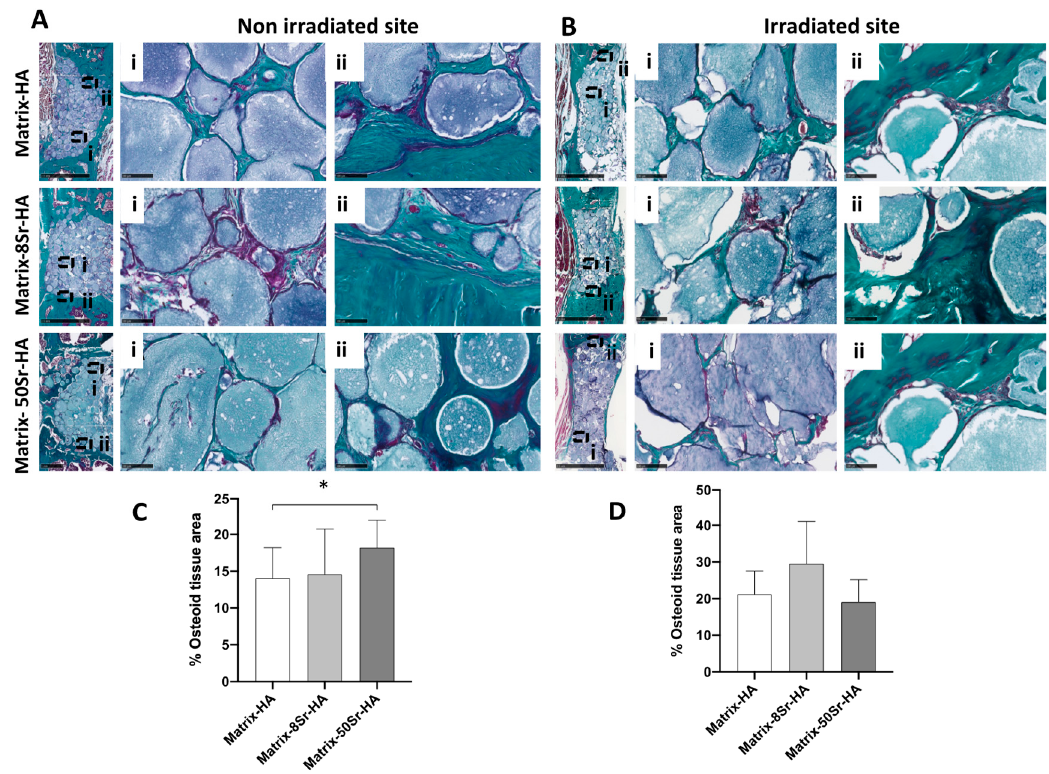
Figure 7. Histological analysis of the newly formed tissue the within the Matrix-HA groups supplemented or not with strontium after radiation procedure: ( A , B ) Masson’s trichrome staining of the newly formed tissue within the three groups of microbeads (Matrix-HA, Matrix-8Sr-HA, and Matrix-50Sr-HA) without or after irradiation procedure: ( A ) non-irradiated versus ( B ) irradiated site after 12 weeks of implantation. ( C , D ) Quantitative analyses of the newly bone surface in mm². Results were expressed as average ± SD per group of microbeads (Matrix-HA, Matrix-8Sr-HA, and Matrix-50Sr-HA) for both groups: ( C ) non-irradiated site versus ( D ) irradiated site. The symbol * denotes p < 0.05.